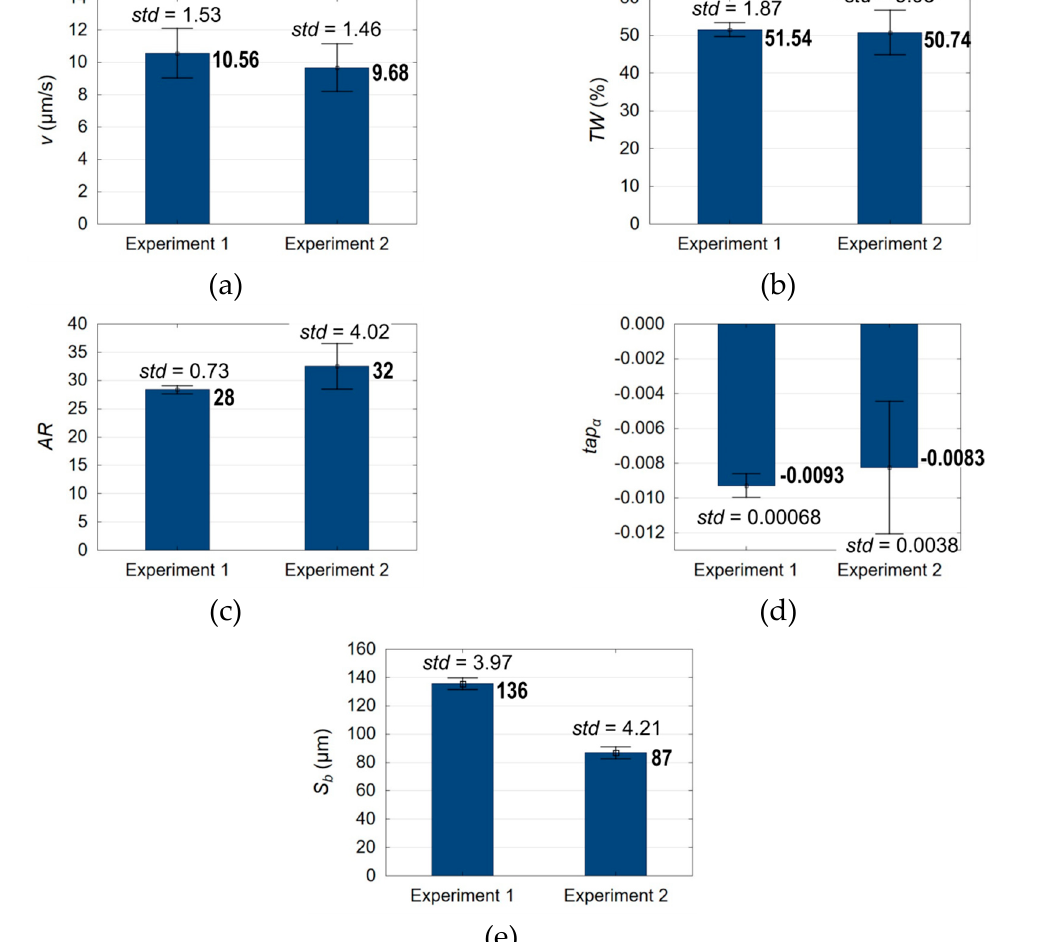
Figure 20. Comparison of the process performance in Experiments 1 and 2 for: (a) the drilling speed v , (b) the linear tool wear TW , (c) the aspect ratio hole AR , (d) the taper angle tap α , and (e) the side gap thickness S b ; std – the value of the standard deviation.